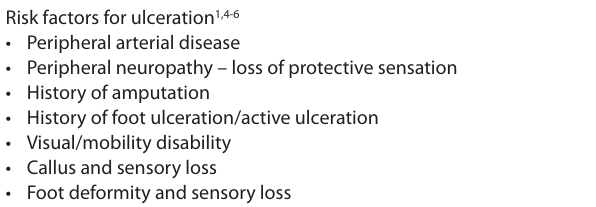
Table 1: Risk factors for ulceration Risk factors for ulceration 1,4-6